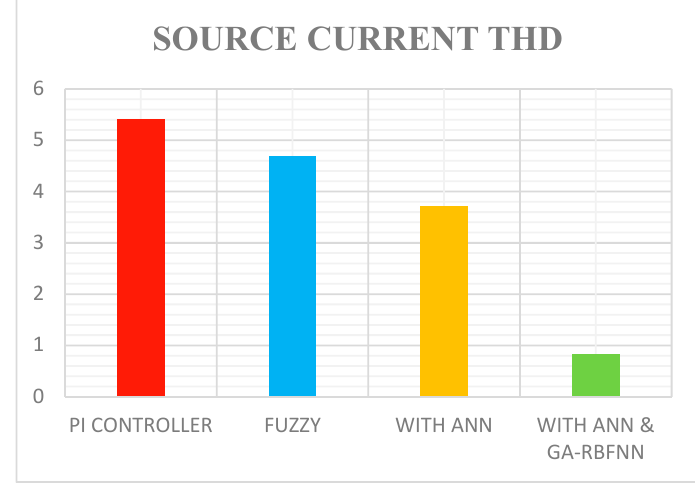
Figure 20. Comparison of source current THD.